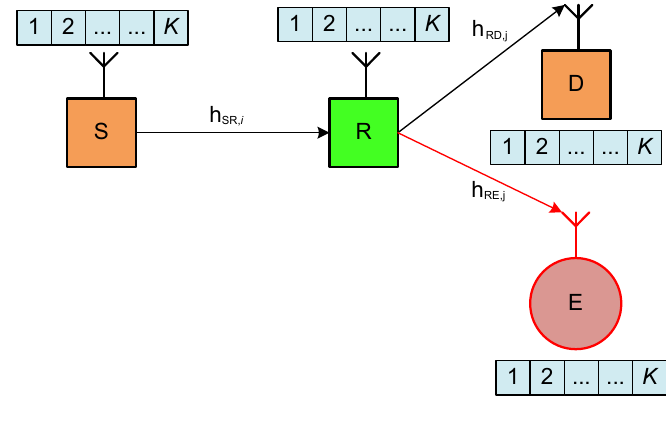
Figure 1. A decode-and-forward (DF) relay network with an